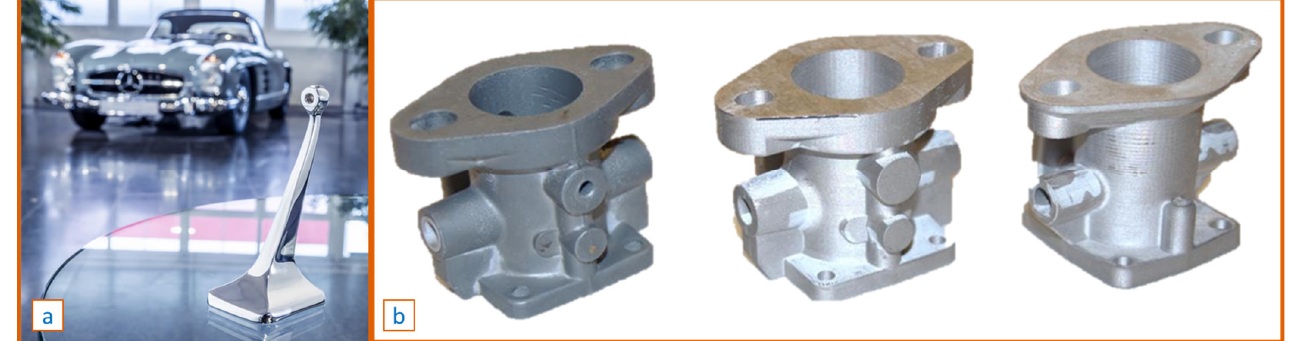
Figure 5. Metal spare-part reconstruction based on direct AM processes: ( a ) Mercedes 300 SL Coupè mirror base (photo credits: Mercedes-Benz Group AG). ( b ) Steyr 220 carburettor body ( left ), 3D- printed original design ( centre ), 3D-printed DfAM design ( right ) (photo credits: Tecron s.r.o.).